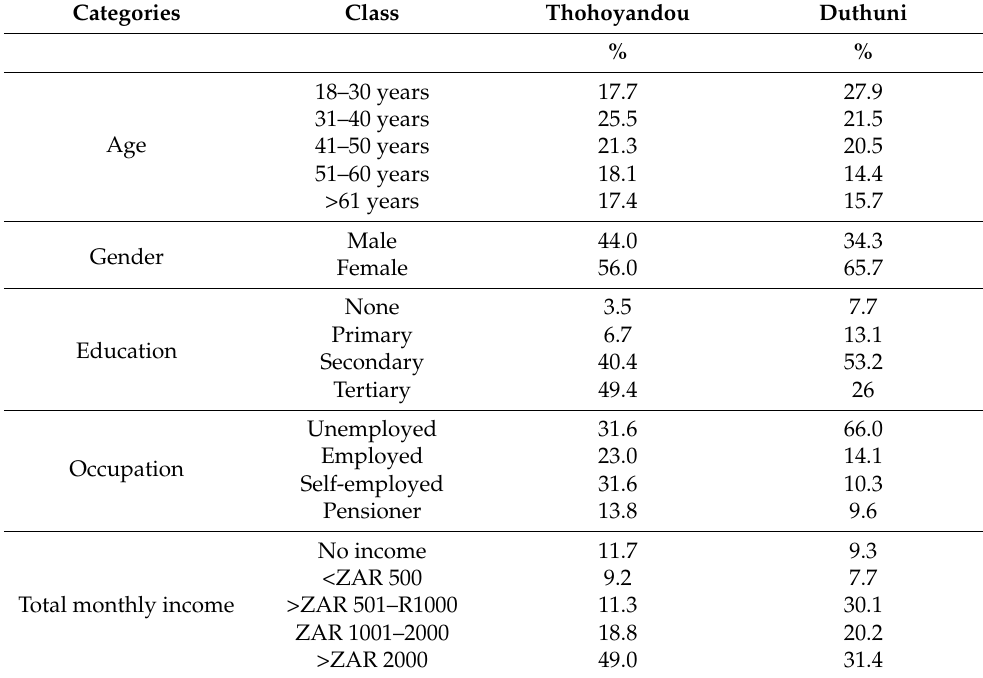
Table 1. Socioeconomic profile of the respondents in Thohoyandou town ( n = 282) and Duthuni village ( n = 312) in Limpopo Province of South